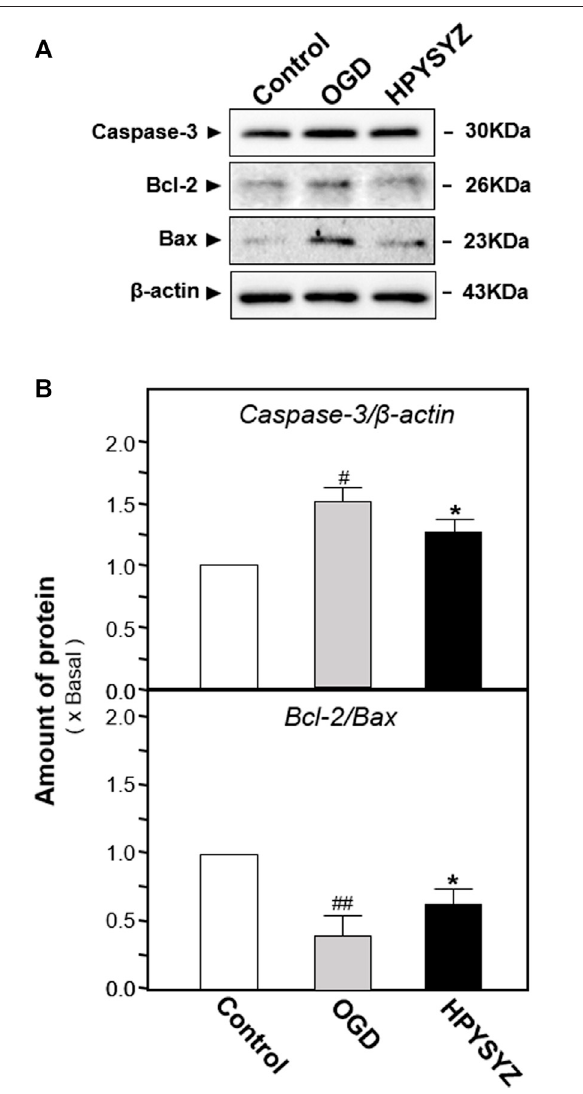
FIGURE 10 | Ethyl acetate extracts of succinum regulated the caspase- dependent pathway of HT22 cells under OGD condition. (A) Effects of ethyl acetateextractsofsuccinum(HPYSYZ)ontheexpressionsofcaspase-3,Bcl- 2, and Bax of HT22 cells under OGD condition were evaluated by Westernblotting analysis.The representative images are displayed ( n = 5). (B) Expression of caspase-3 was analyzed, and the expression of β -actin was applied for normalization. Expressions of Bax and Bcl-2 were analyzed, and theexpressionof β -actinwasalsousedfornormalization.Theexpressionratio ofBcl-2toBaxwascalculated.Valuesareexpressedasthepercentage ofthe controlgroup(nodrugtreatment group)asmean±SEM( n =5).Comparisons between groups were analyzed by a one-way ANOVA followed by a post hoc Bonferronitest. ## p < 0.01(comparedwithcontrolgroup),* p < 0.05,and** p < 0.05 (compared with the OGD model